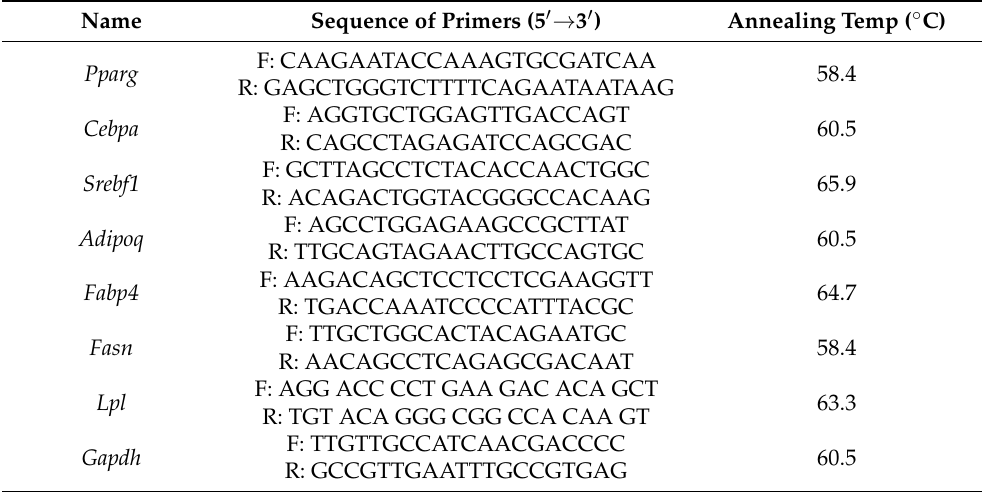
Table 1. Oligonucleotide sequence used in quantitative